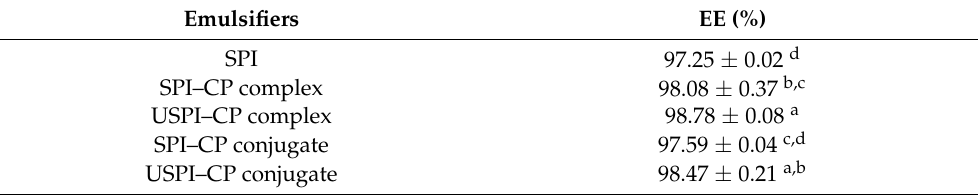
Table 2. EE of β -carotene nanoemulsions prepared using different types of